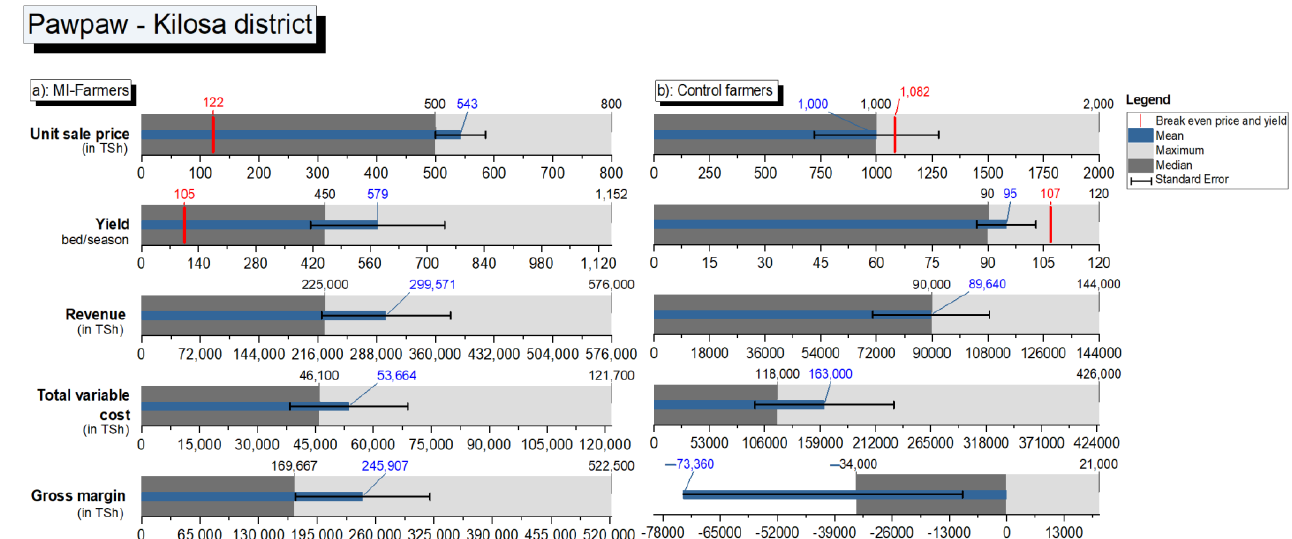
Figure 8. Enterprise comparison of MI farmers ( a ) and control farmers ( b ) growing pawpaw in the Kilosa district. Price, revenue, total variable cost (TVC), and gross margin (GM) amounts are presented in Tanzanian Shilling (TSh), where 1 USD = 2330 TSh and 1 TSh = 0.00043 USD. Yield is calculated as per bed per season. Standard error of mean is presented as error bars for each bar graph.